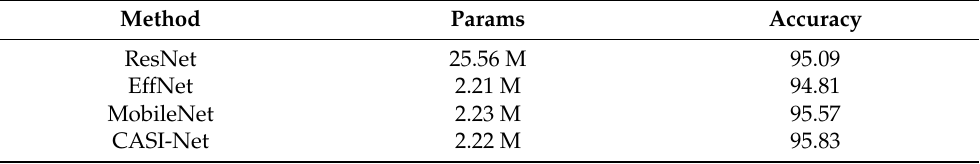
Table 2. The accuracy (%) and the params of CASI-Net with state-of-the-art